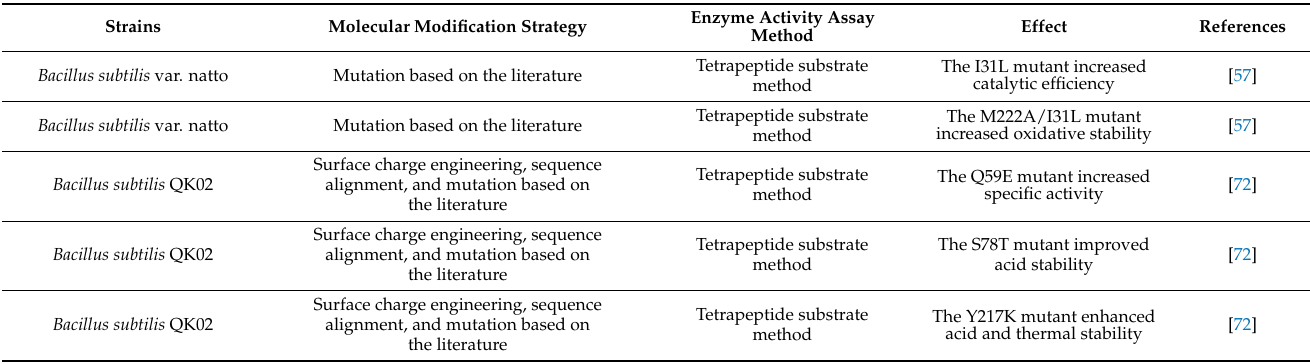
Table 5. Enzyme engineering to improve the enzymatic properties of